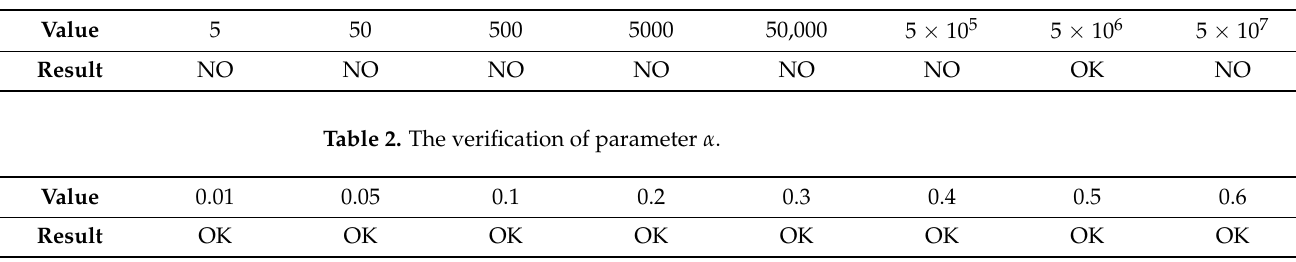
Figure 9. Curves of the error signals with faults (Agent 3). ( a ) Curve of the error signal of Fault 1. ( b ) Curve of the error signal of Fault 2. ( c ) Curve of the error signal of Fault 3. To better illustrate the effectiveness of the proposed method, a simulation verifica- tion on the two key parameters that affect the diagnosis performance is carried out. The simulation statistical results are shown in Tables 1 and 2. The result in the table is “OK”, which indicates that there is a feasible solution to the LMI inequality, and the fault infor- mation can be diagnosed accurately. If the result is “NO”, the LMI inequality cannot ob- tain a feasible solution with this parameter, and the corresponding fault information can- not be accurately diagnosed. Table 1. The verification of parameter φ . Value